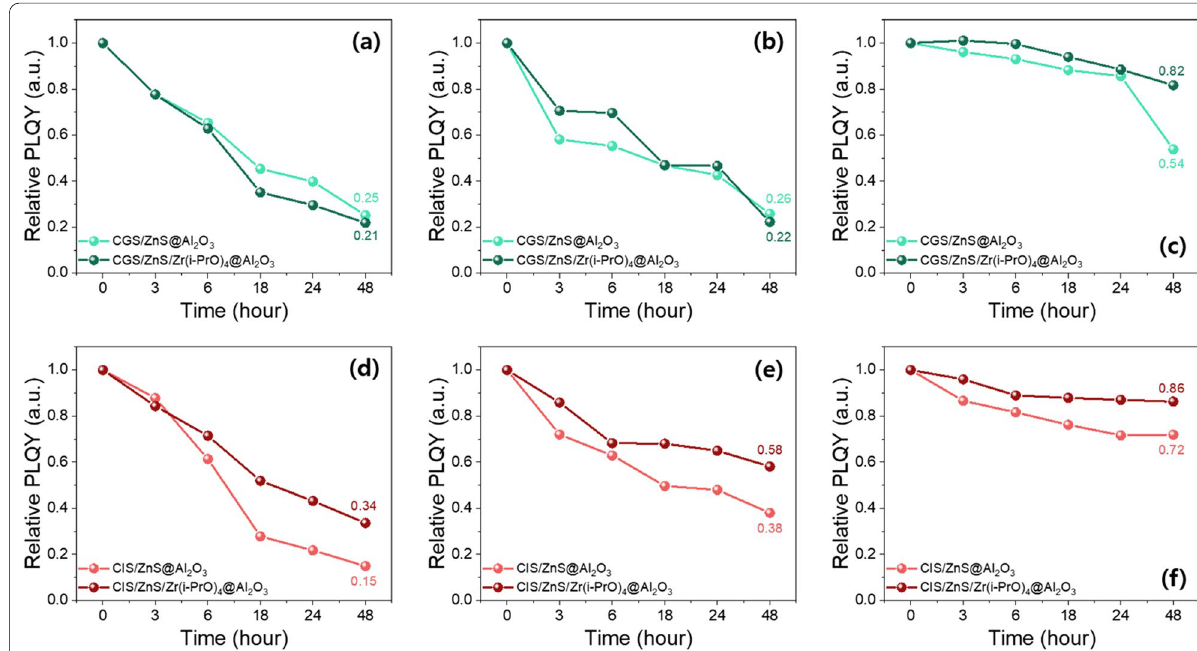
Fig. 9 a Photograph (under UV irradiation) and b thermal stability (120 °C heating condition) and c moisture resistance (under 85H/85T) of green Al 2 O 3 encapsulated CGS/ZnS based QD hybrid powders. and d photograph and e thermal stability and f moisture resistance of red Al 2 O 3 encapsulated CIS/ZnS based QD hybrid